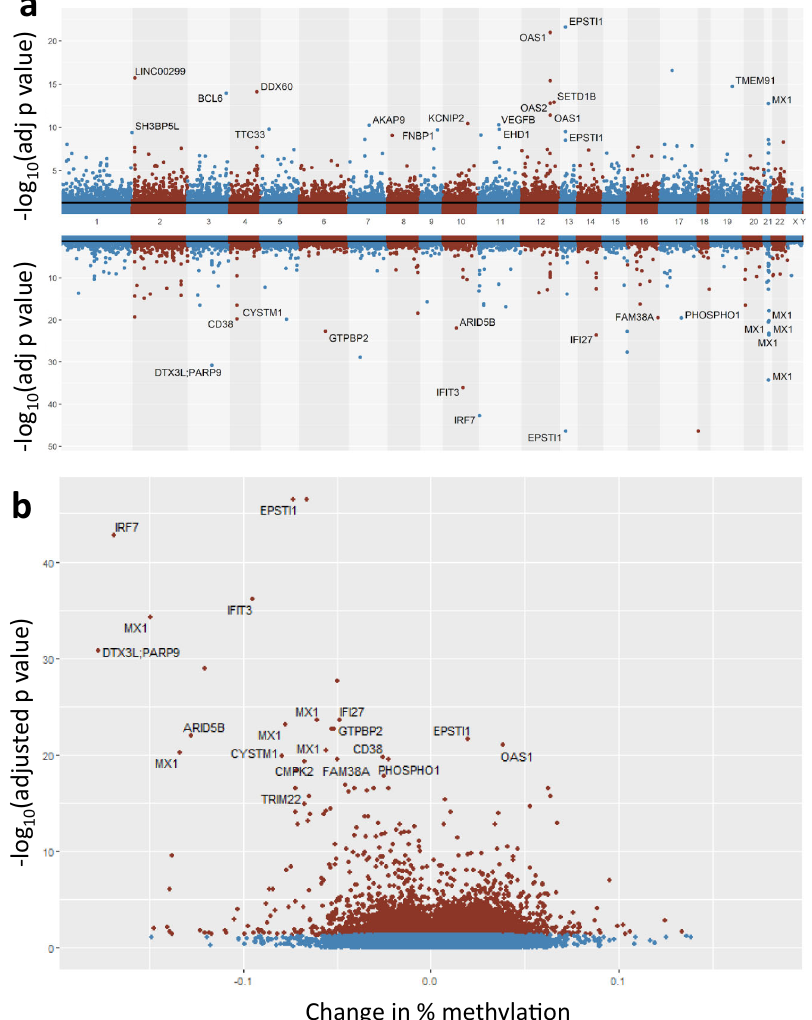
Fig. 2 Differentially methylated CpGs associated with SARS-CoV-2 infection. a Miami plot (top panel) of hypermethylated (top) and hypomethylated (bottom) probes in SARS-CoV-2 + compared to control samples. Signi fi cance lines represent FDR-adjusted P value <0.05 threshold. b Volcano plot of signi fi cant (red; FDR-adjusted P value <0.05) CpG sites (blue CpG sites have FDR-adjusted P value >0.05). Change in percentage methylation on the x axis represents the difference in average beta value at a site between cases and controls. Probes for intergenic CpG sites do not have gene annotations. Data used to plot this fi gure are available as Supplementary